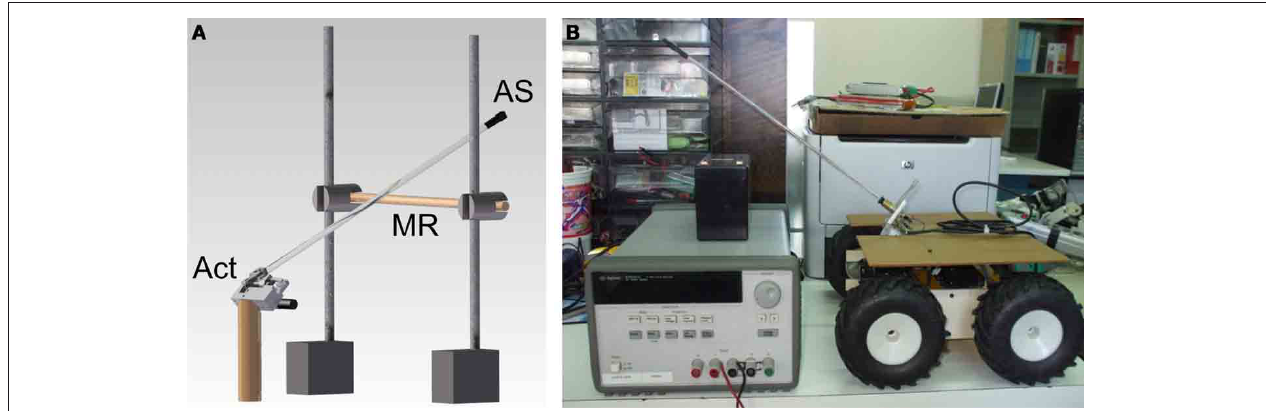
FIGURE 1 | Bionic antenna and robotic platform. (A) Stationary setup for experiments on tactile localization and material classification. The probe consisted of a polyacrylic beam with a distal acceleration sensor, AS. It was actuated by a custom-built two-axis actuator platform, Act, using DC-motors